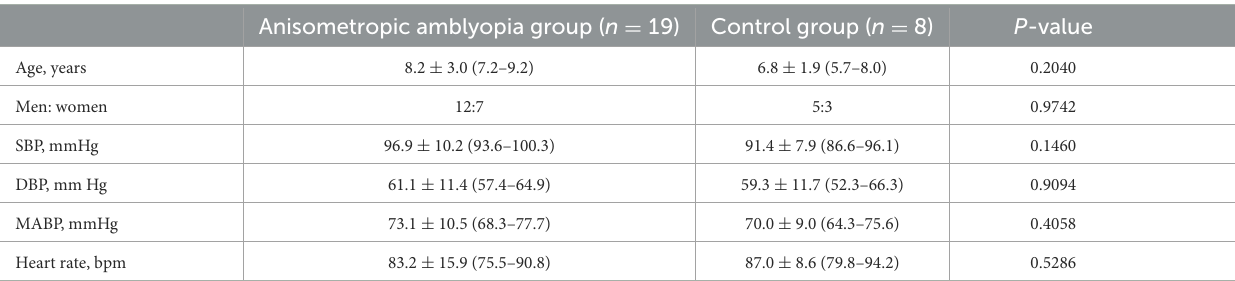
TABLE 1 Demographics and clinical characteristics of the study